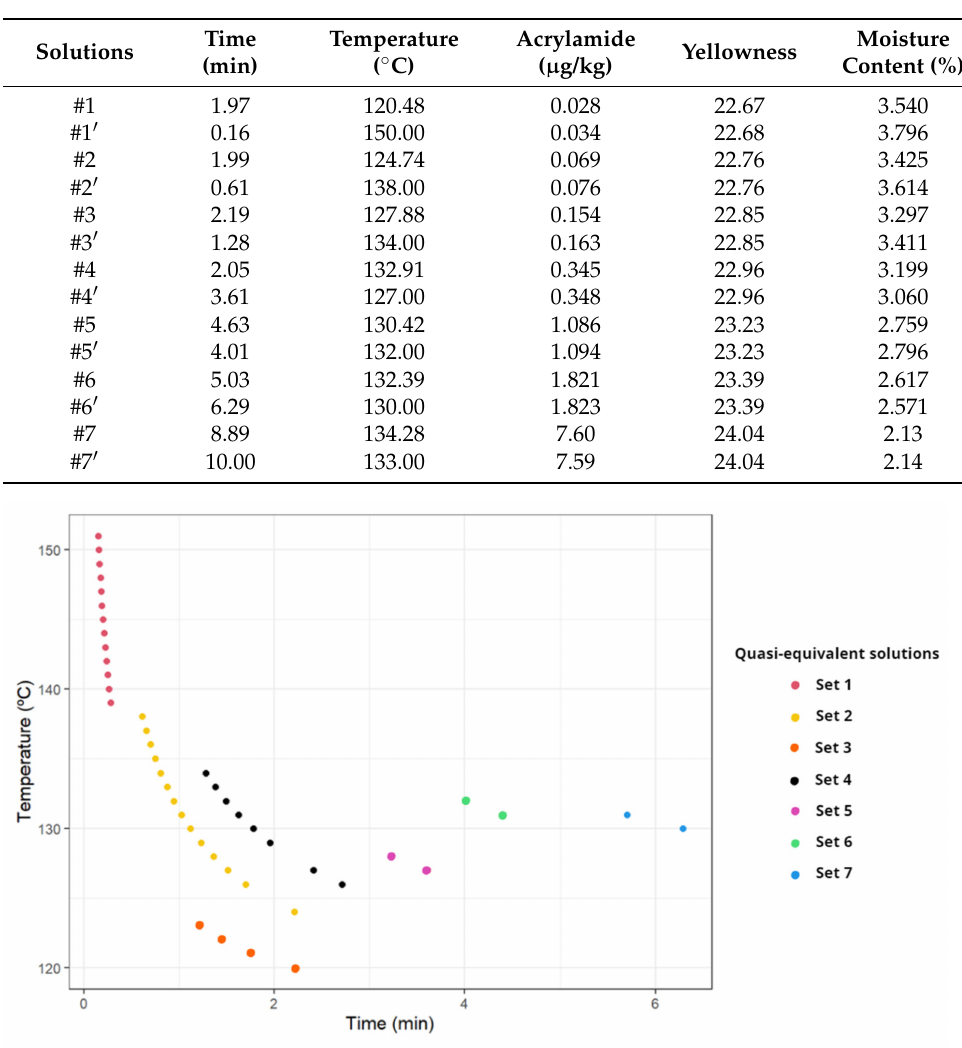
Table 1. Selection of Pareto fronts and quasi-equivalent solutions.